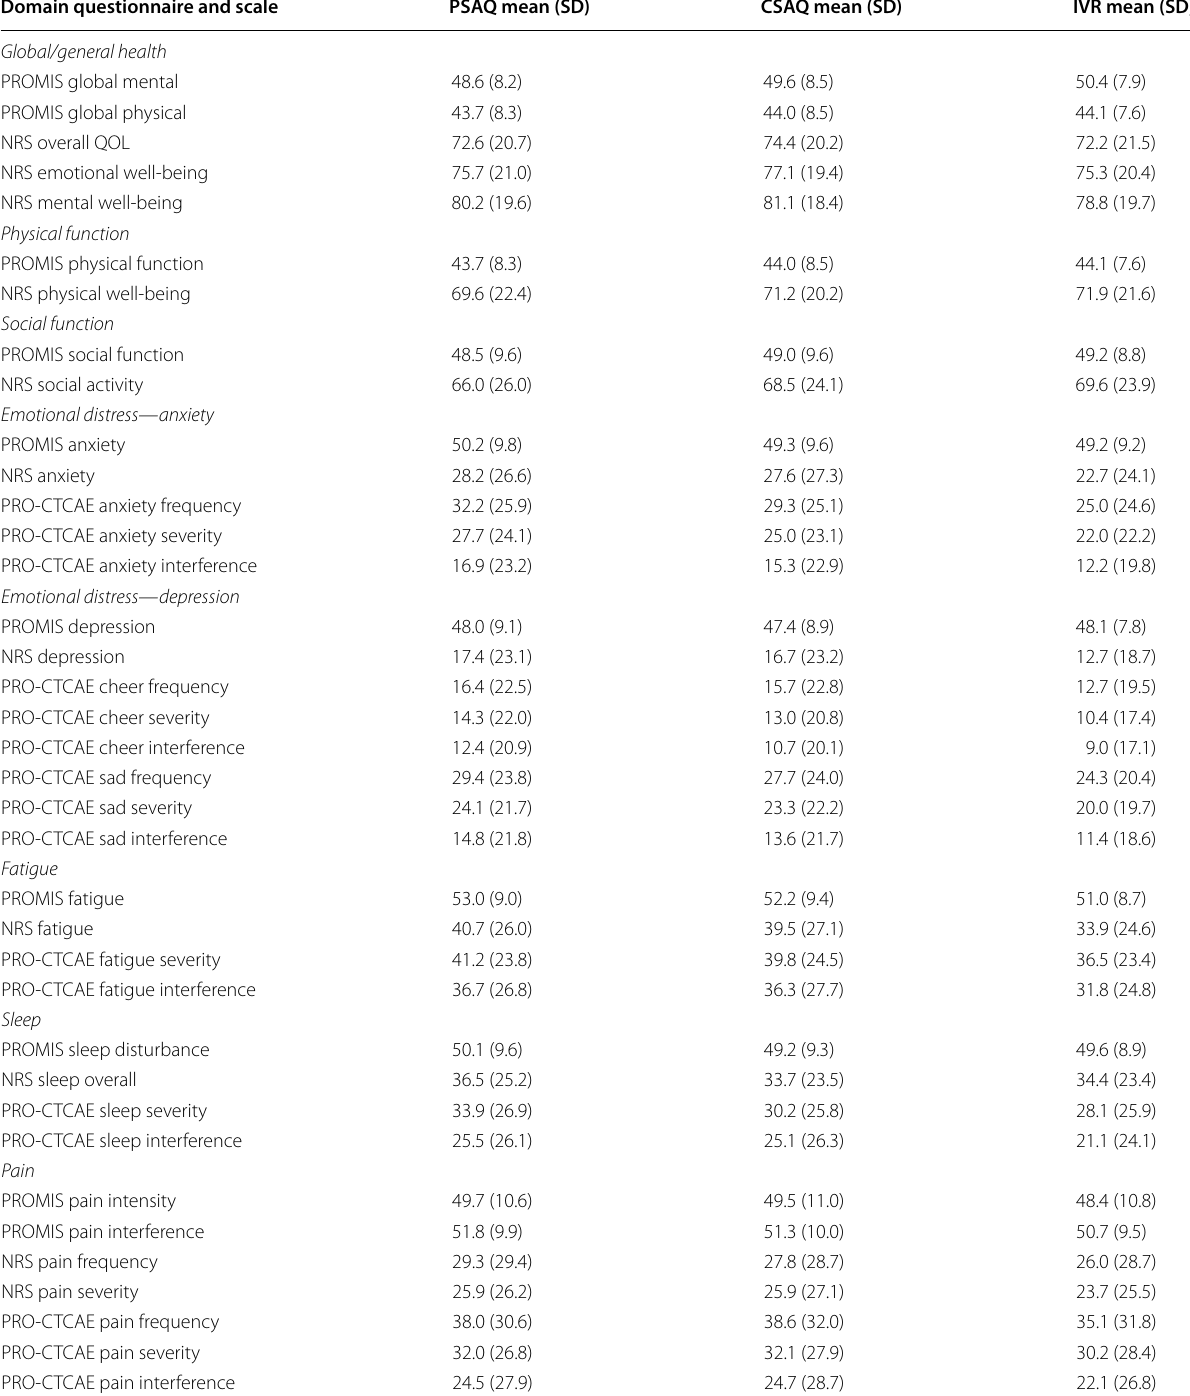
Table 3 Health-related quality of life (HRQOL) scores by mode of